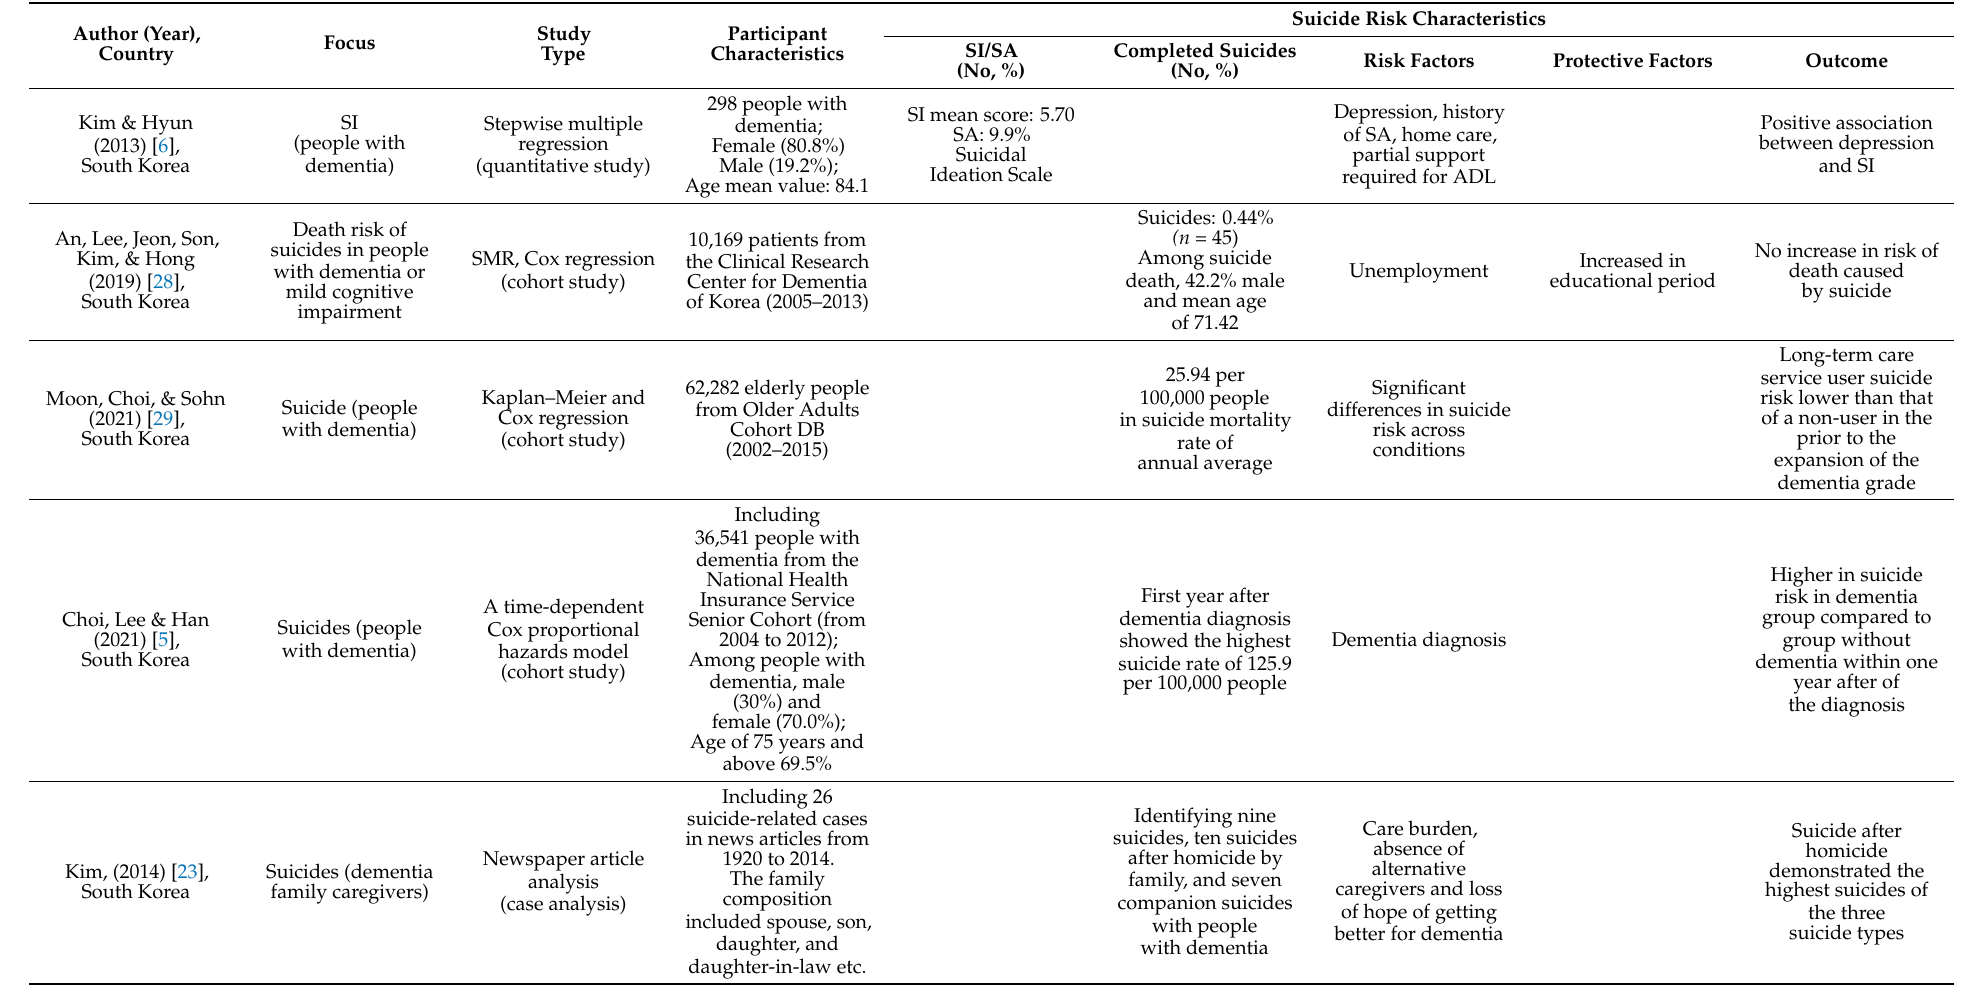
Table 1. Characteristics of suicide risk among people with dementia and dementia family